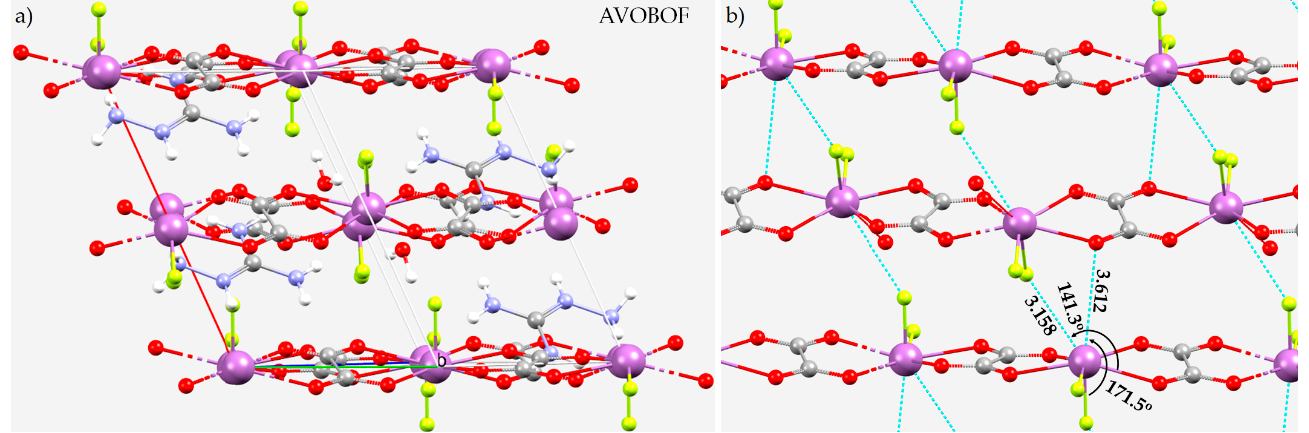
Figure 20. ( a ) The unit-cell of the crystal structure of (CN 4 H 7 )SbC 2 O 4 F 2 (H 2 O) 0.5 . Shown in ( b ) is the local coordination environment around the Sb center in the crystal. Selected bond lengths and bond angles are in Å and degree, respectively. The CSD ref. code in capital letters is marked. Atoms are shown as small spheres and bonds as lines in atom color, whereas the intermolecular interactions are represented by dotted lines in cyan. Atom color: Sb—purple; O—red; F—green; C—gray; H—white-gray; N—blue. The [CN 4 H 7 ] + and H 2 O moieties in ( b ) are removed for clarity.